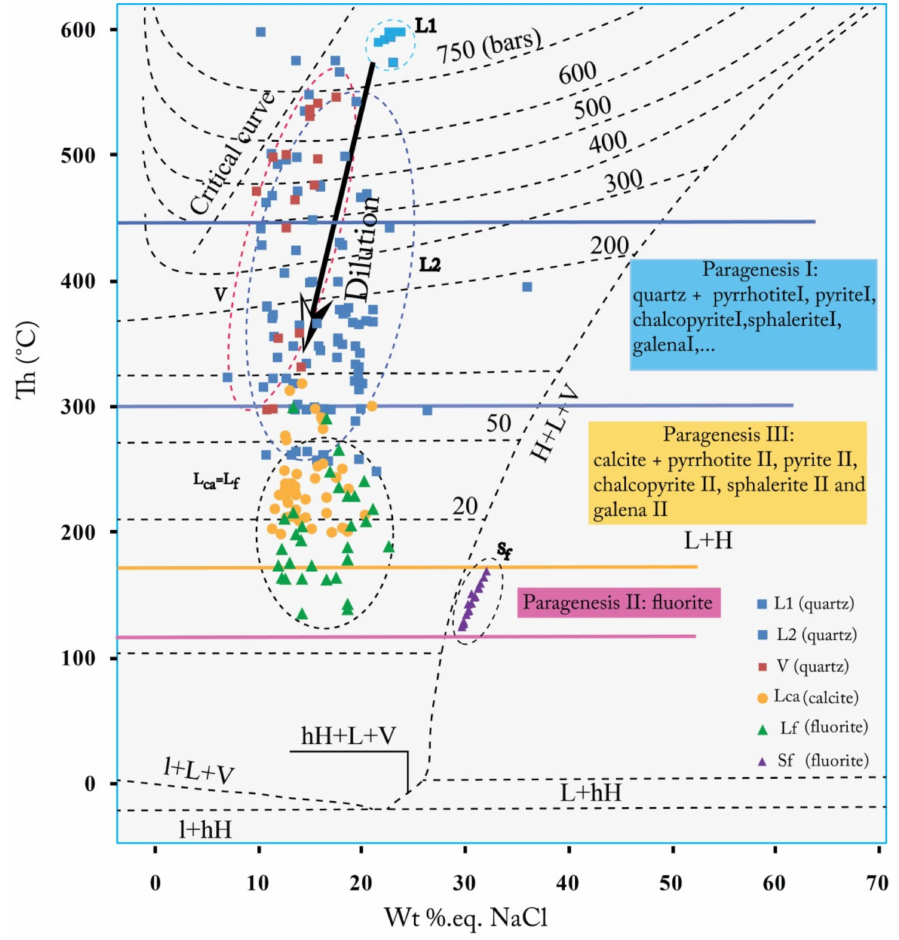
Figure 23. Salinity vs. homogenization temperature dispersion diagram with isobar sections of fluid inclusions of type L, V, and S encountered in the NNE-A sector. L: Liquid; V: Vapor; S: